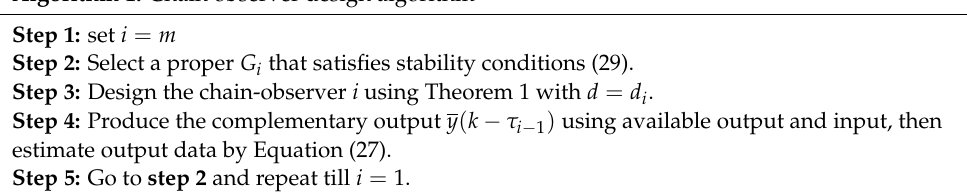
Algorithm 1. Chain observer design algorithm